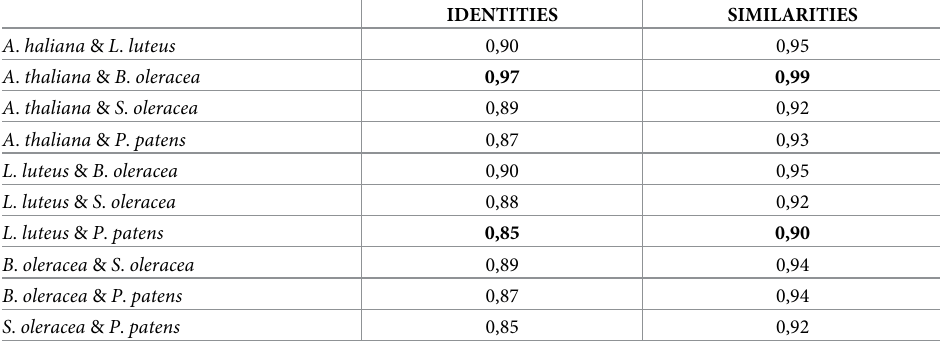
Table 1. Pair-wise comparison of SAHH1 amino acid sequences from A . thaliana , L . luteus , B . oleracea , S . oleracea and P . patens . Identities and similarities are shown. IDENTITIES